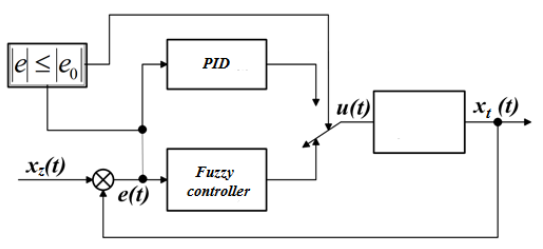
Figure 5. Transient process during the develop- ment of a fuzzy regulator with exponential (1), piecewise linear (2) and Gaussian function (3) near the positioning point of the pneumatic actua- tor carriage